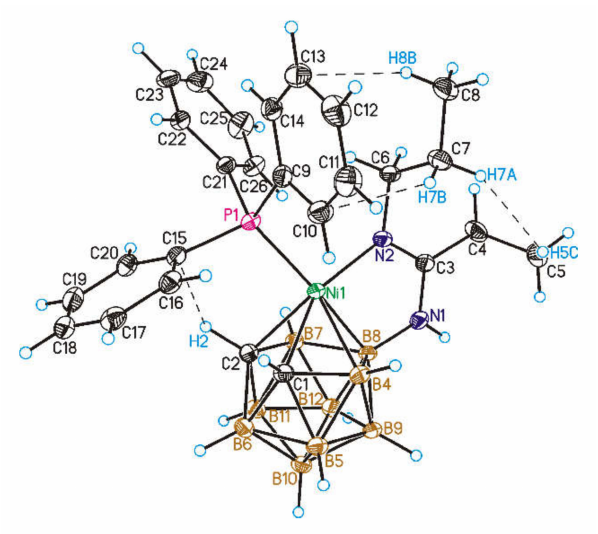
Figure 1. General view of the nickel(II) complex [3-Ph 3 P-3-(8-Pr N =C(Et)NH)- closo -3,1,2-NiC 2 B 9 H 10 ] ( 2 ). Thermal ellipsoids are given at 50% probability level. Shortened contacts are shown by dashed